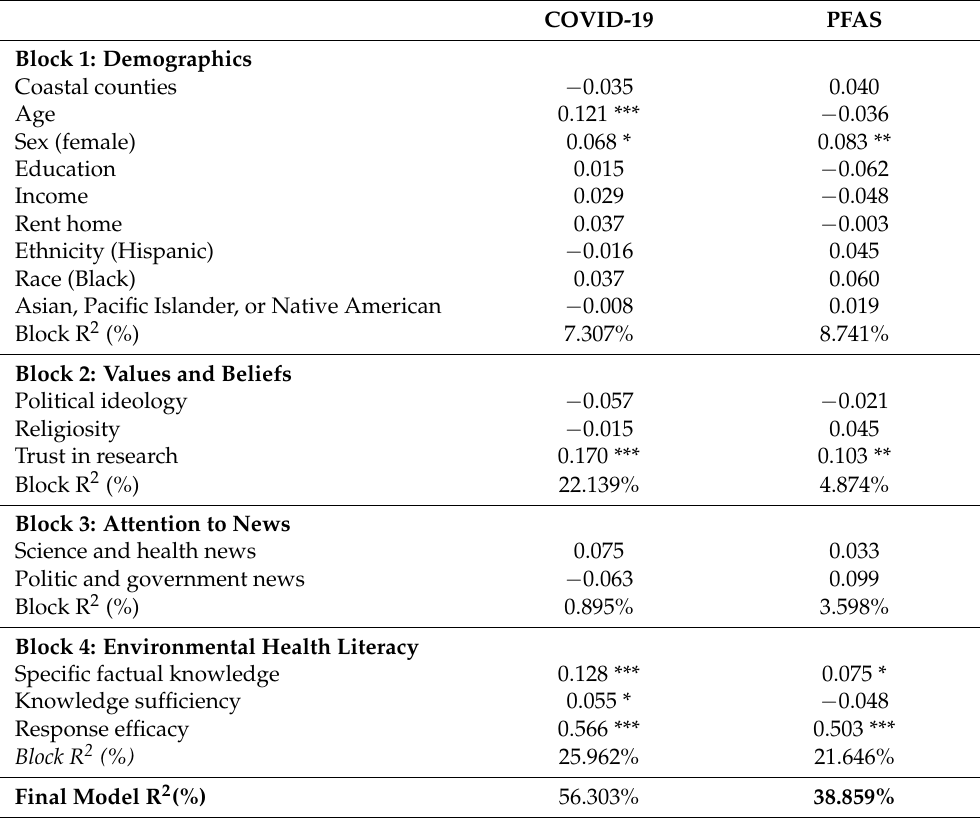
Table 3. Results of final multiple regressions 3 predicting willingness to engage in protective behaviors against COVID-19 and PFAS based on demographics, values/beliefs, news use, and environmental health literacy. COVID-19